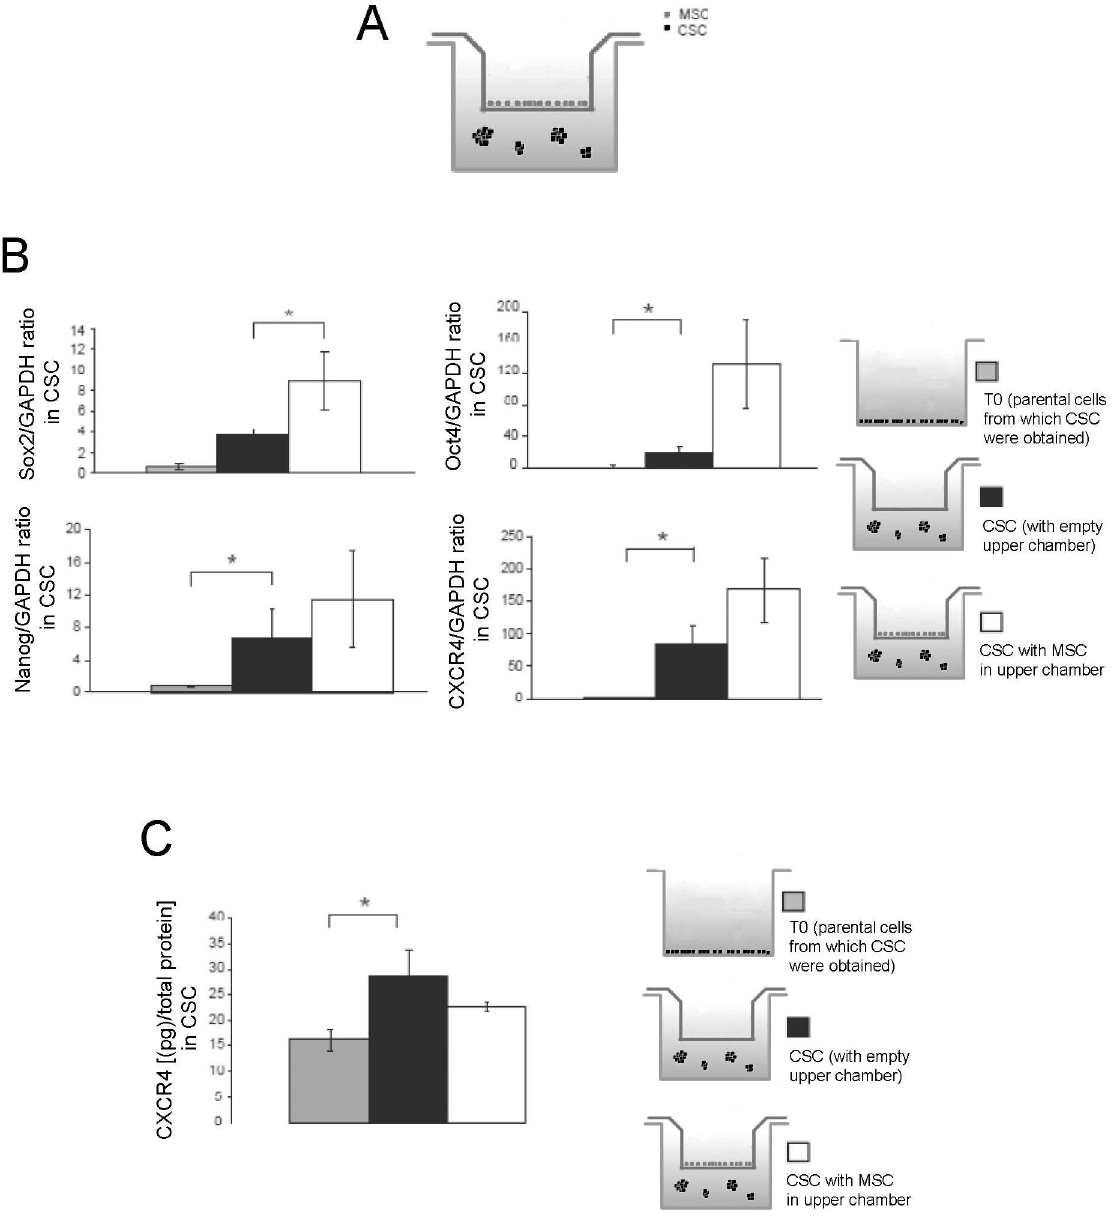
Fig 1. Gene expressionof stem-cell markersconfirmed the enhancement of stem-like featuresof CSC when are co- cultured with MSC in transwell. (A) Scheme of the co-culture system of HOS-CSCwith MSC used in this study. The co- culturingwas prolongedfor 3 days; (B) Sox2, Oct4, Nanog, and CXCR4 expressionevaluatedby Real Time PCR in HOS-CSC spheresthat were cultured alone or with MSC (in transwell). Gene expressionof CSC was also comparedto parentalHOS adherentcells (T0) ( * p < 0.05); (C) CXCR4 was also evaluatedby ELISA. ( * p < 0.05). Note that the levels of Oct4, Nanog, and CXCR4 markers in the sphereswere significantly higherthan the parentalcell line. For Sox2, we saw a similar trend of increase in CSC spheresrespect to parentalcells, althoughthis increasewas more evidentwhen CSC where co-cultured with